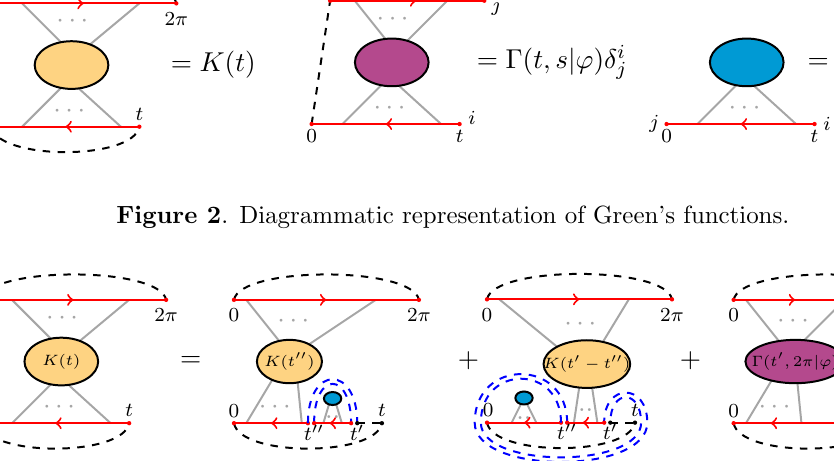
Figure 3 . Diagrammatic interpretation of the integral equation (2.14).